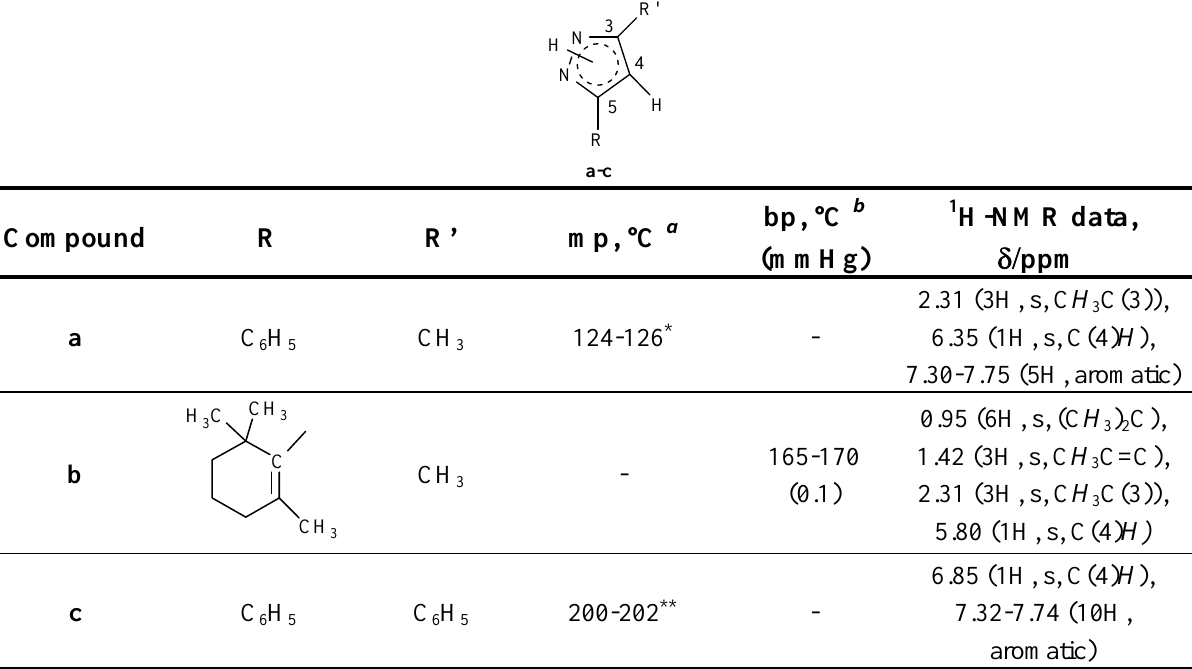
Table 1. Physical and chemical properties of products a-c obtained under microwave activation. N